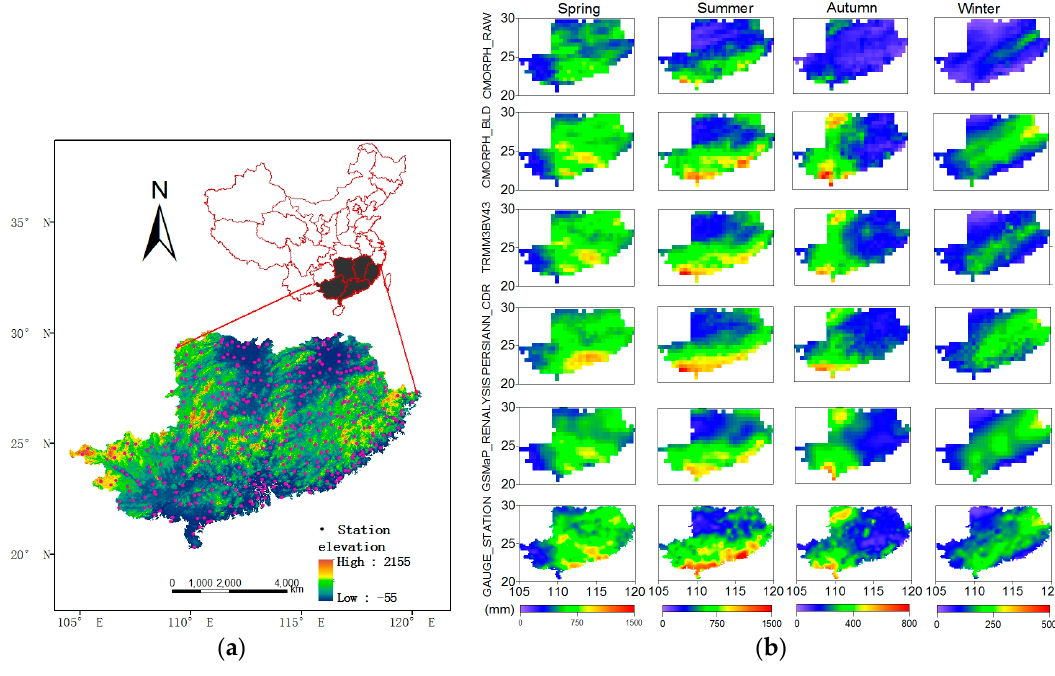
Figure 11. The precipitation distributions from the rain gauge stations ( a ) and multiple satellites ( b ) in 2013 over southern China.